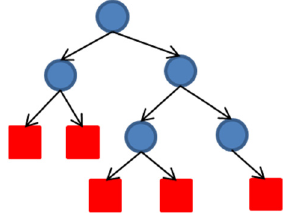
Figure 8. Illustration of decision tree.